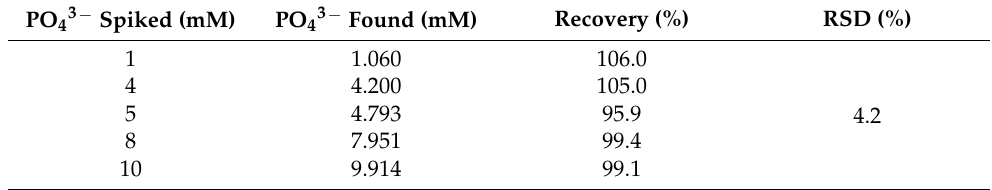
Table 1. Results and recovery of samples ( n = 3).